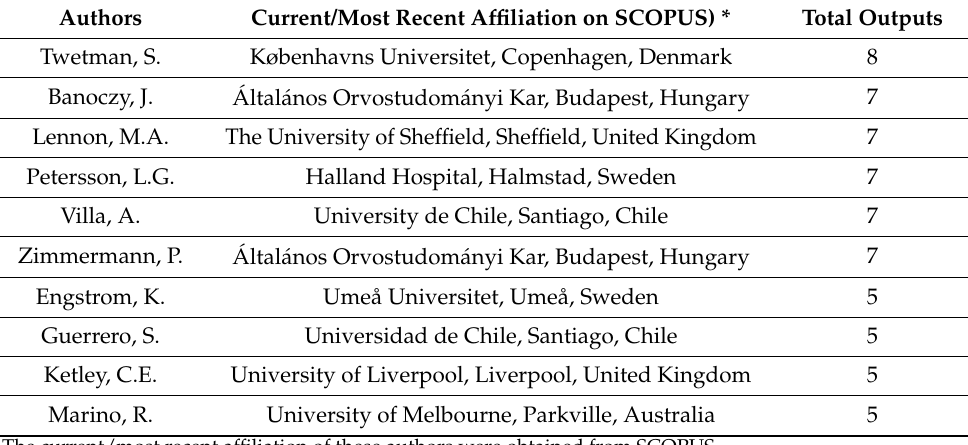
Table 3. Top ten authors of original research articles on milk fluoridation.